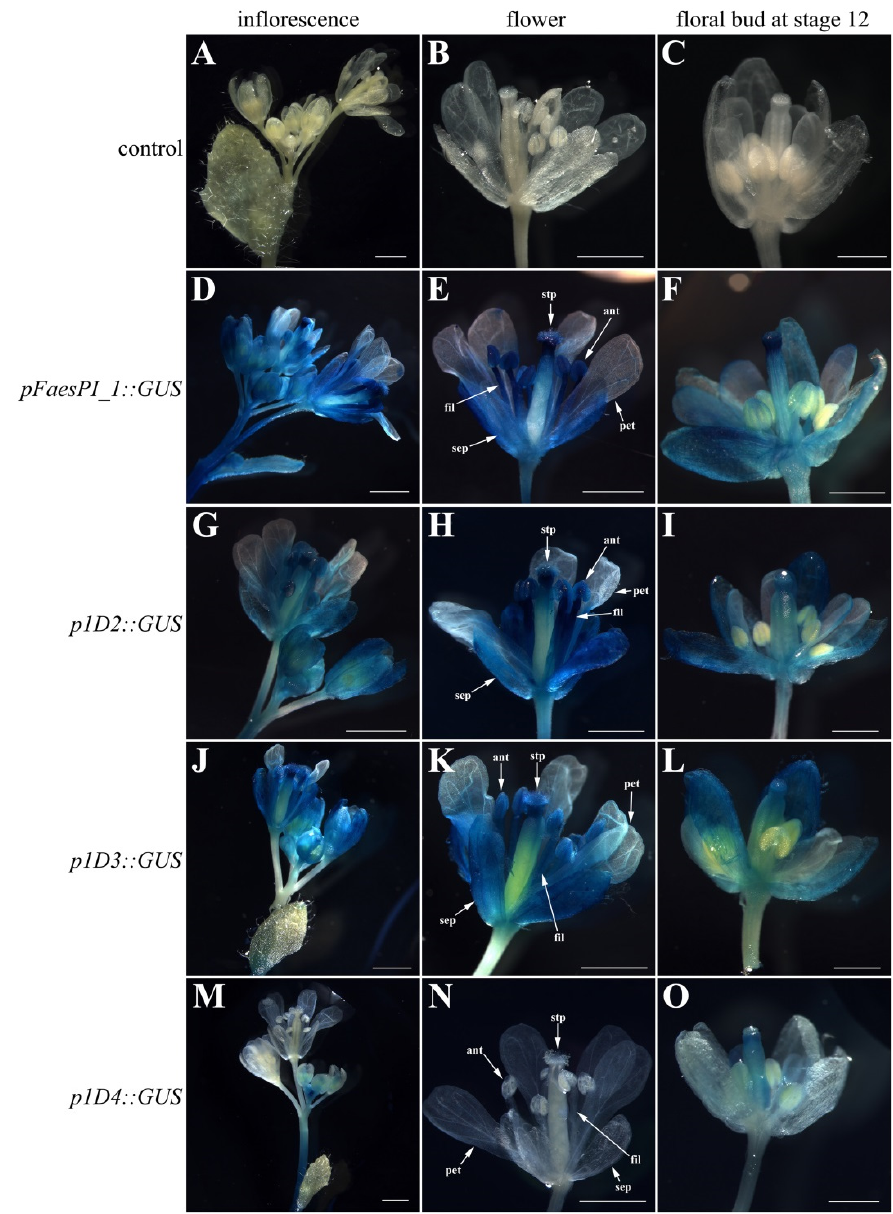
Figure 6. Histochemical GUS staining in the T1 generation of pFaesPI_1::GUS transgenic Arabidopsis and deletion analysis of the pFaesPI_1 promoter. ( A ) wild-type Arabidopsis Inflorescence; ( B ) wild- type Arabidopsis flower; ( C ) stage 12 floral bud of wild-type Arabidopsis [25]; ( D ) inflorescence of pFaesPI_1::GUS transgenic Arabidopsis ; ( E ) mature flower of pFaesPI_1::GUS transgenic Arabidopsis ; ( F ) stage 12 floral bud of pFaesPI_1::GUS transgenic Arabidopsis ; ( G ) inflorescence of p1D2::GUS transgenic Arabidopsis ; ( H ) mature flower of p1D2::GUS transgenic Arabidopsis ; ( I ) stage 12 floral bud of p1D2::GUS transgenic Arabidopsis ; ( J ) inflorescence of p1D3::GUS transgenic Arabidopsis ; ( K ) mature flower of p1D3::GUS transgenic Arabidopsis ; ( L ) stage 12 floral bud of p1D3::GUS transgenic Arabidopsis ; ( M ) inflorescence of p1D4::GUS transgenic Arabidopsis ; ( N ) mature flower of p1D4::GUS transgenic Arabidopsis ; ( O ) stage 12 floral bud of p1D4::GUS transgenic Arabidopsis . sepal (sep), petal (pet), anther (ant), filament (fil), stigmatic papillae (stp); Scale Bars: ( A , B , D , E , G , H , J , K , M , N ) 1 mm; ( C , F , I , L , O ) 500 μ m.